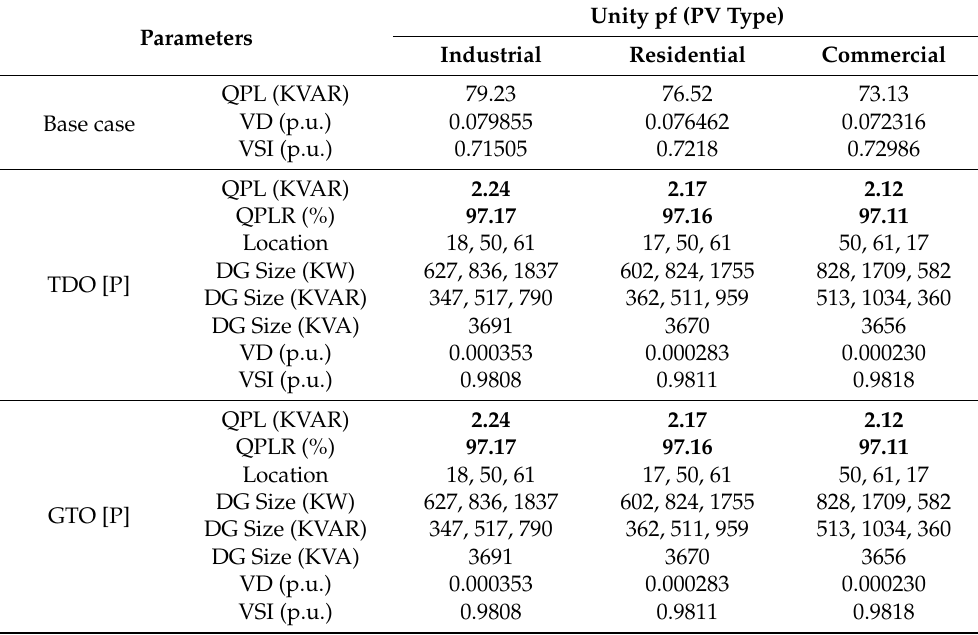
Table A8. Results of OADG for a 69-bus RDN for SOF (QPL minimization) at 0.85 pf (WT type) in a VP load